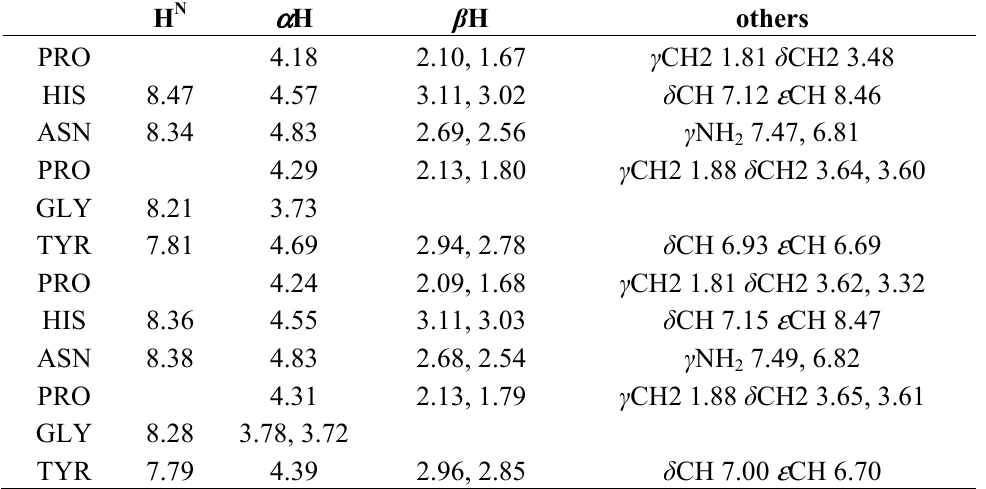
O (300 K, pH 4.2). 2